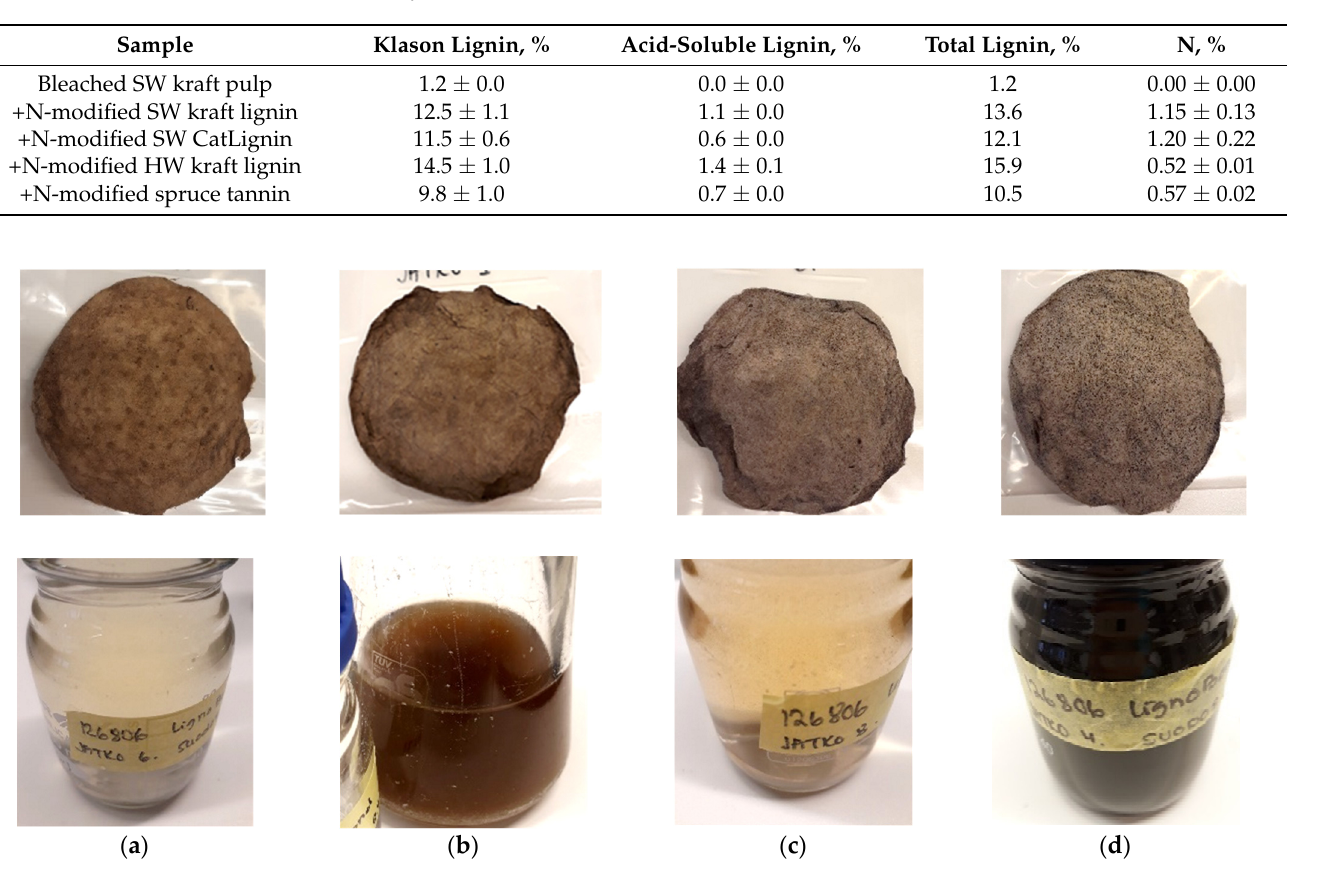
Figure 4. Pulp fibre pads (top image) and filtrates (bottom image) after LignoBond deposition of N-modified biopolyphenols: ( a ) SW kraft lignin, ( b ) SW CatLignin, ( c ) HW kraft lignin, and ( d ) Spruce tannin.